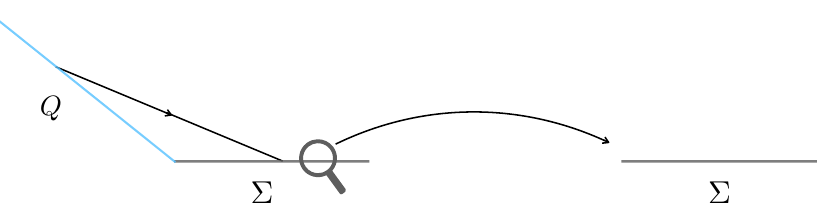
Figure 15 . The IR-sensitive nonlocality in the intermediate picture. The left figure shows a time slice of the intermediate picture where the arrow shows a superluminal propagation from Q to Σ induced from a shortcut in the bulk. When zooming in to UV, one can only see Σ , and no nonlocality will be observed within Σ .